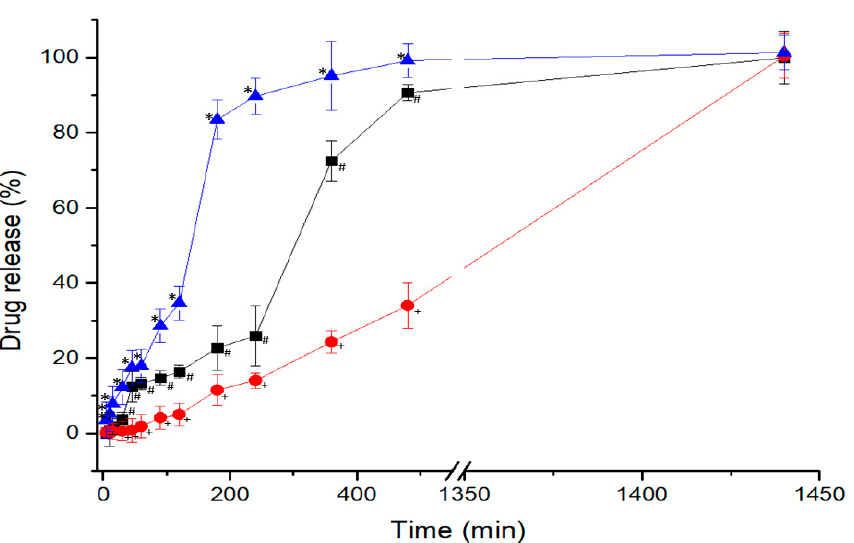
Figure 6. Dissolution profile for the 3D printed minitablets formulation (- ■ -) compared to the commercially marketed NFD tablets: Adalat Oros ® 30 mg (- ● -) and Adalat Retard ® 20 mg (- ▲ -). Key: + p < 0.05 Adalat Oros ® vs. all the other formulations (including t = 15 min); # p < 0.05 3D printed minitablets formulation vs. the marketed formulations (including t = 15 min) and * p < 0.05 Adalat Retard ® vs. all the other formulations.